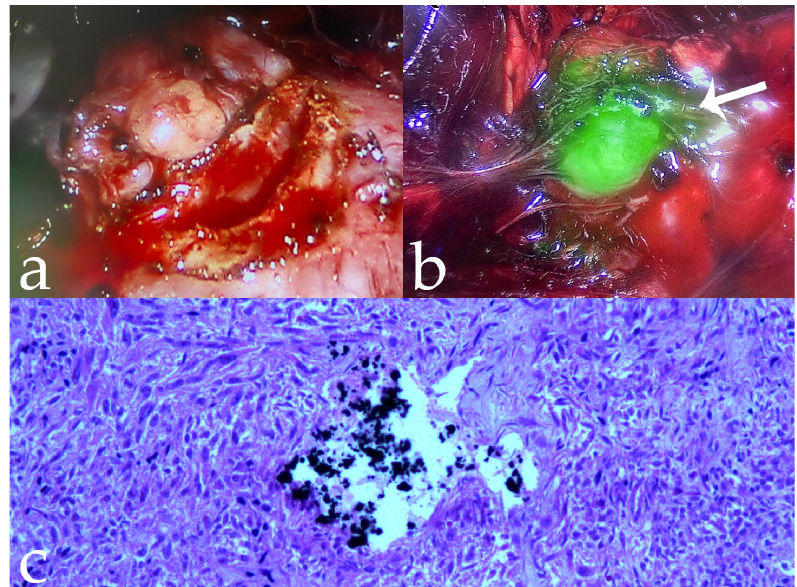
Figure 5. Same case as Figures 3 and 4. ( a , b ) Tumor intra-operative visualization during robotic- assisted enucleation before and after fluorescence imaging (arrow); ( c ) histological findings showing deep penetration of 18-Onyx (10×).